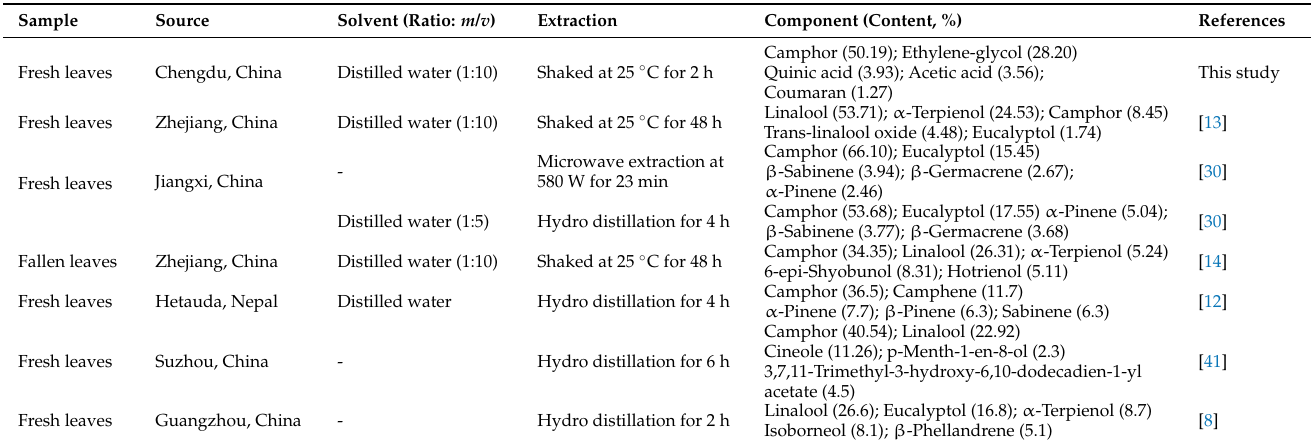
Table 3. The chemical components of C. camphora water